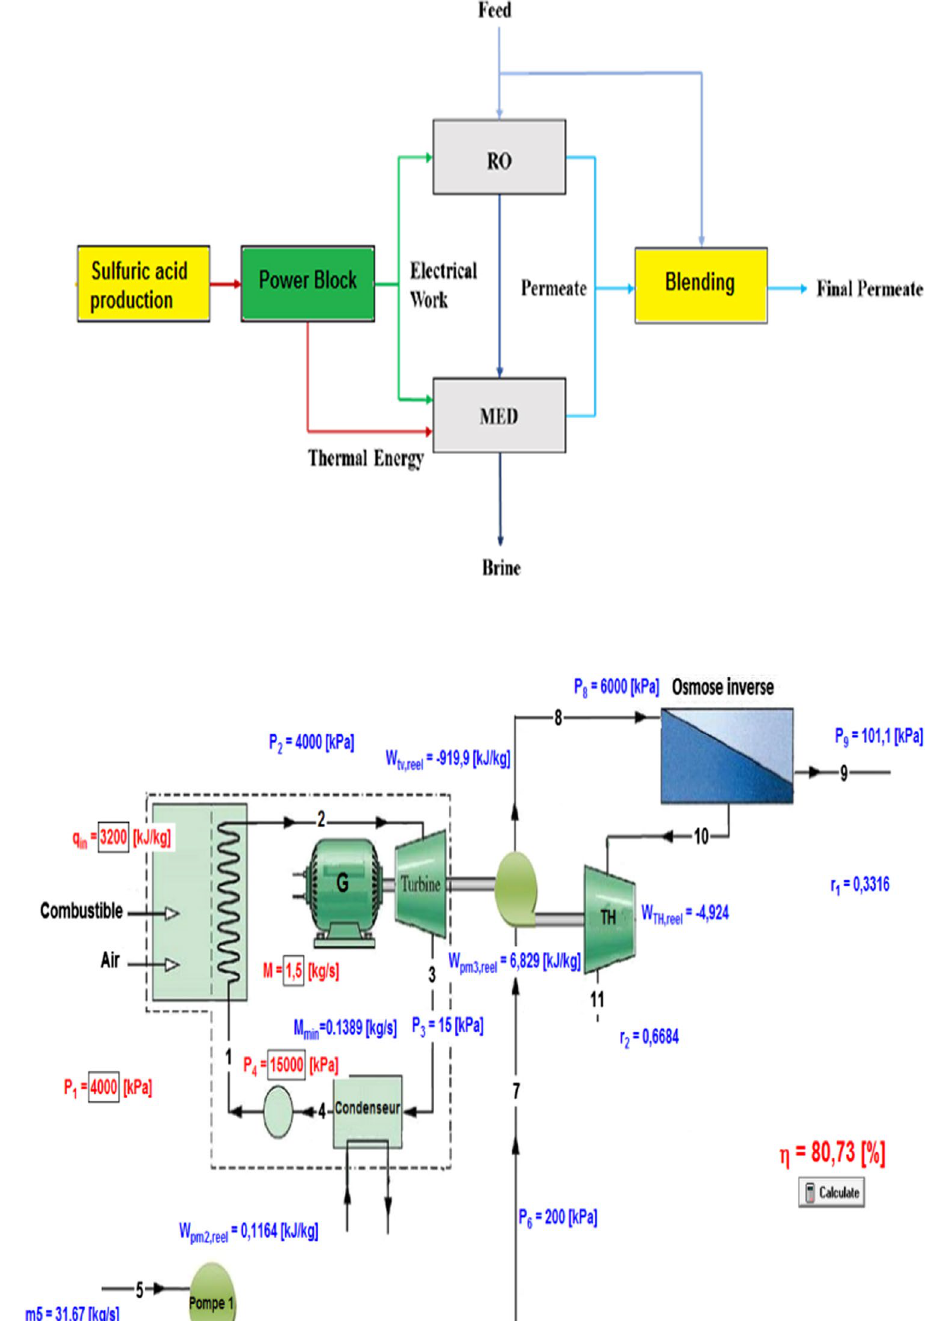
Fig. 6 Diagram of heat recovery in production of sulfuric acid